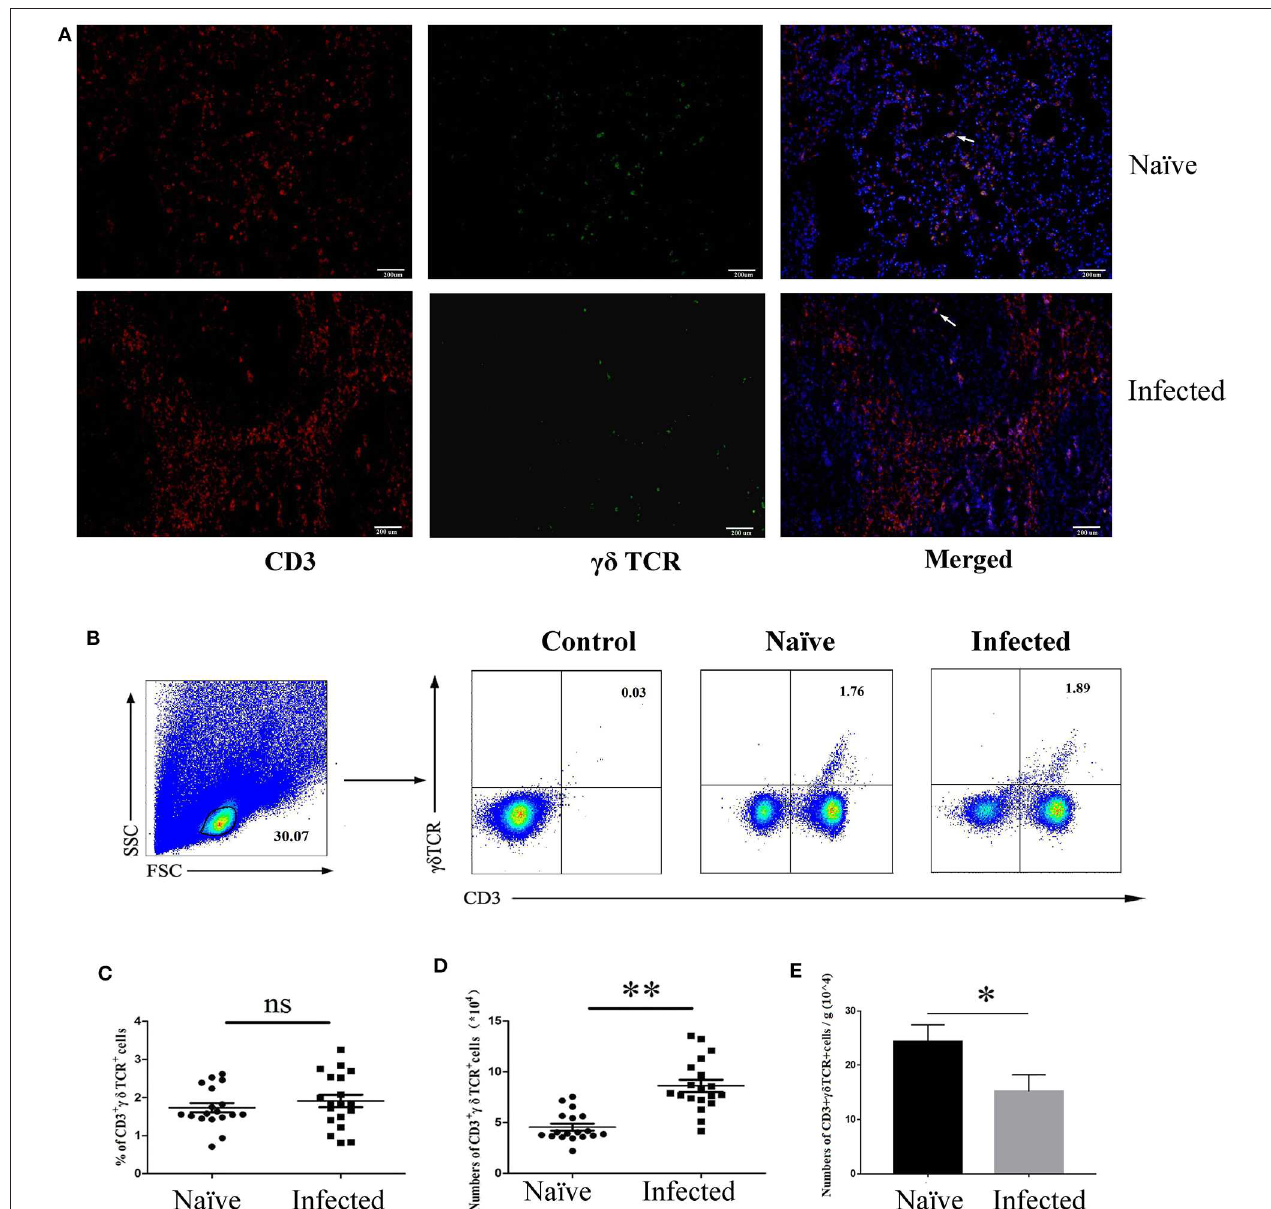
FIGURE 1 | Distribution and content of γδ T cells in S. japonicum -infected mouse lungs. Female C57BL/6 mice were infected with 40 ± 5 S. japonicum cercariae per mouse, and 5–6 weeks after infection, mice were euthanized. (A) Fluorescence staining was performed on paraffin sections of lung tissue from infected mice. CD3 (Red) and γδ TCR (Green) are identified by different fluorescence, and nuclei are visualized using DAPI staining (Blue). A representative experiment from three independent experiments was shown. Scale bar, 200 µ m. (B) Pulmonary cells were stained with anti-CD3 and anti- γδ TCR mAbs. The percentage of CD3 + γδ TCR + cells in the lungs of naïve and infected mice were analyzed by FCM. One representative experiment was shown. The percentage (C) and absolute number (D) of CD3 + γδ TCR + cells per mouse, and the number of γδ T cells in per gram of lung tissues (E) were calculated from three independent experiments with 5–6 samples, respectively. ** P < 0.01, * P > 0.05, ns P >